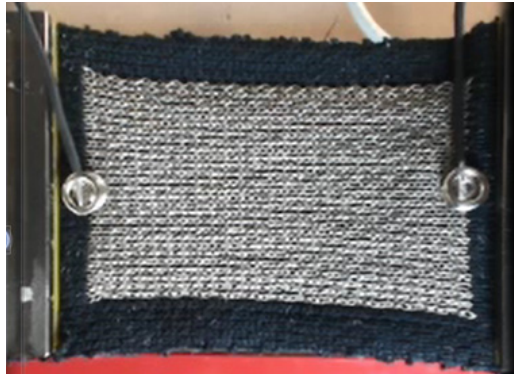
Figure 1. Photograph of the knitted